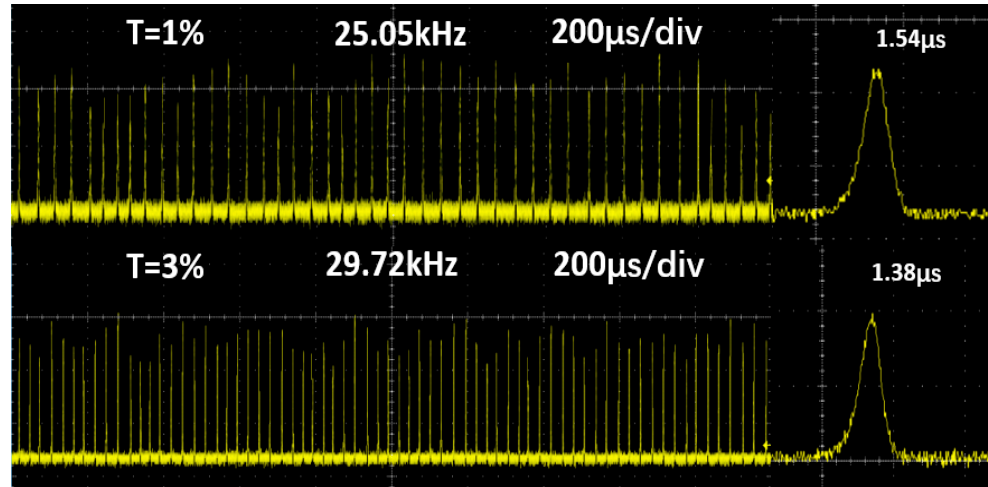
Figure 7. Oscilloscope display of PQS pulse trains at the maximum output power.